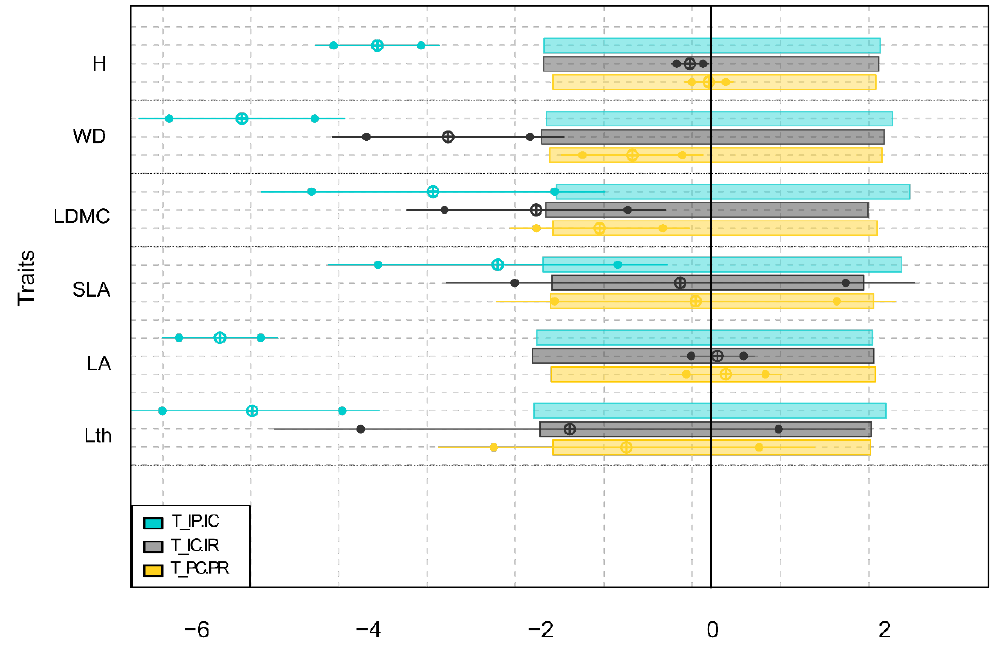
Figure 4. Standardized effect size (SES) for three T statistics evaluated on six functional traits in the floodplain forest (igapó and várzea): (1) plant height (H); (2) wood density (WD); (3) leaf dry matter content (LDMC); (4) specific leaf area (SLA); (5) leaf area (LA); (6) leaf thickness (Lth). The T statistics evaluated are (1) T_IP.IC (blue): ratio observed between the variance of the populations and the total variance of the communities at the individual level, (2) T_IC.IR (gray): ratio observed between the variance of each community and the total variance of the regional pool at the individual level, and (3) T_PC.PR (yellow): observed ratio between the variance of each community and the total variance of the regional pool at the population level. The filled circles represent the SES values for each of the two plots sampled according to each statistic and each trait. The crossed circles and the associated line segments represent the mean and standard deviation of the SES values, respectively, for each T statistic. The boxes delimit the confidence interval of each null model by trait: the mean SES (crossed circle) is significantly different from the random distribution if it is not within the box ( p < 0.05).